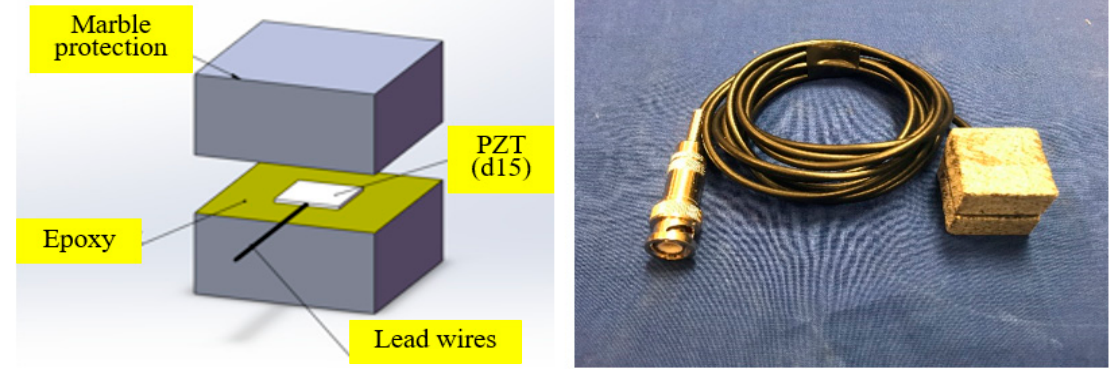
Figure 1. Shear mode SA: ( a ) the structure of a shear mode SA, ( b ) a photo of a shear mode SA.